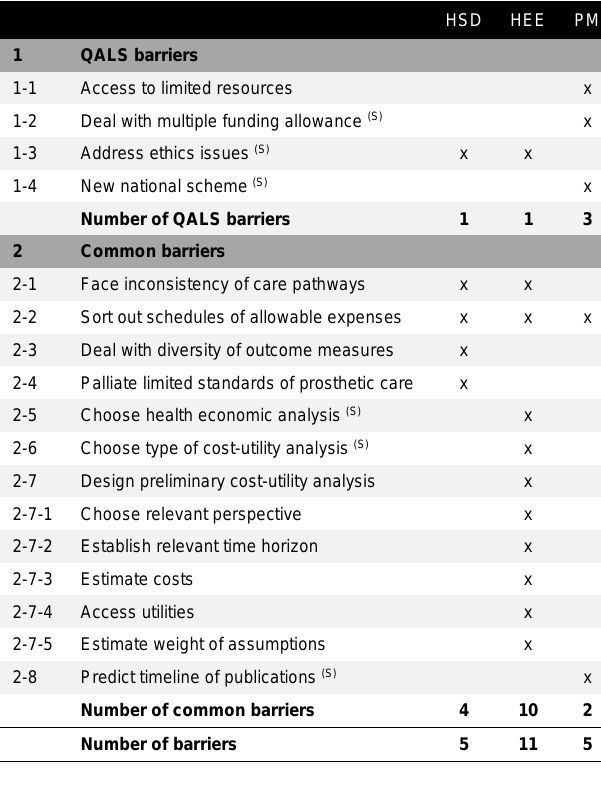
Berg D, Frossard L. Health service delivery and economic evaluation of limb lower bone-anchored prostheses: A summary of the Queensland artificial limb service’s experience. Canadian Prosthetics & Orthotics Journal. 2021; Volume 4, Issue 2, No.12. https://doi.org/10.33137/cpoj.v4i2.36210